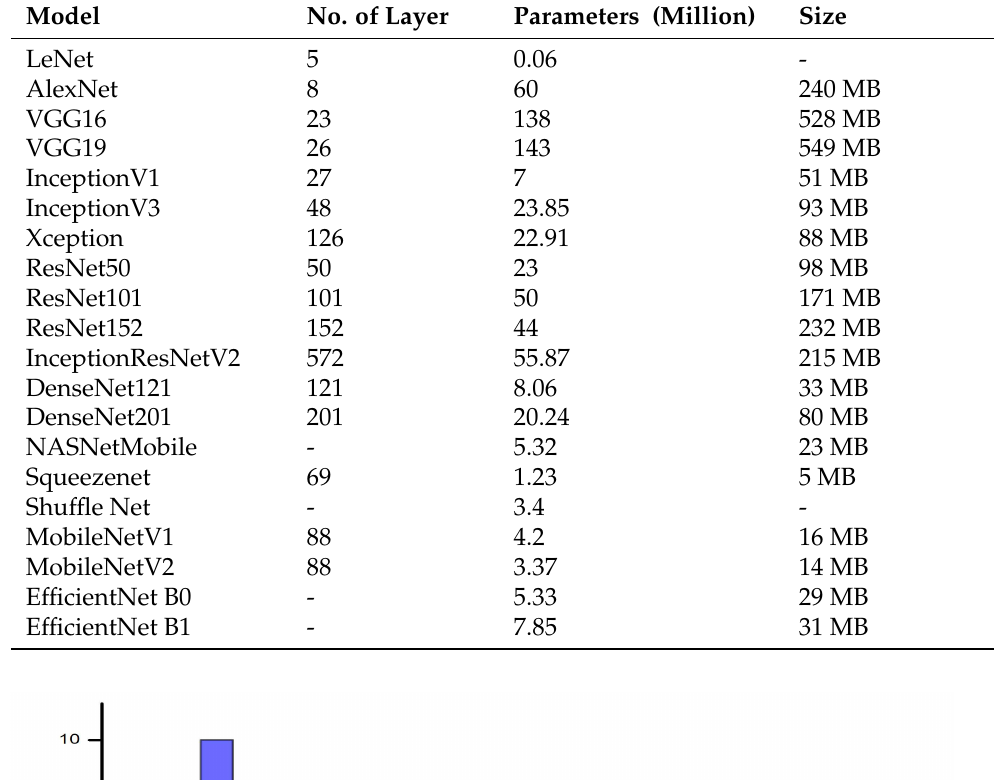
Table 7. Different DL models with respect to number of layers and parameters and size.